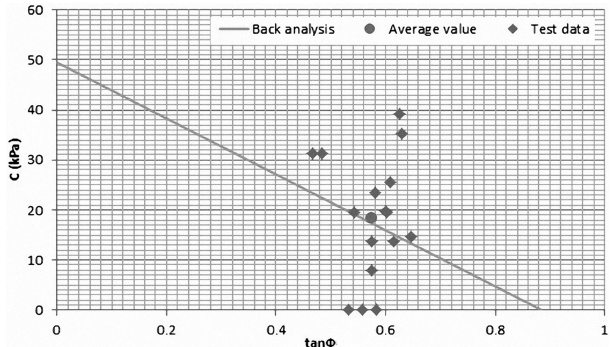
Figure 14. Back analysis of soil parameters for the colluvium layer. The cohesion and friction angles of the colluvium soil adopted were C = 18.5kPa and φ = 29.6 ◦ , respectively.